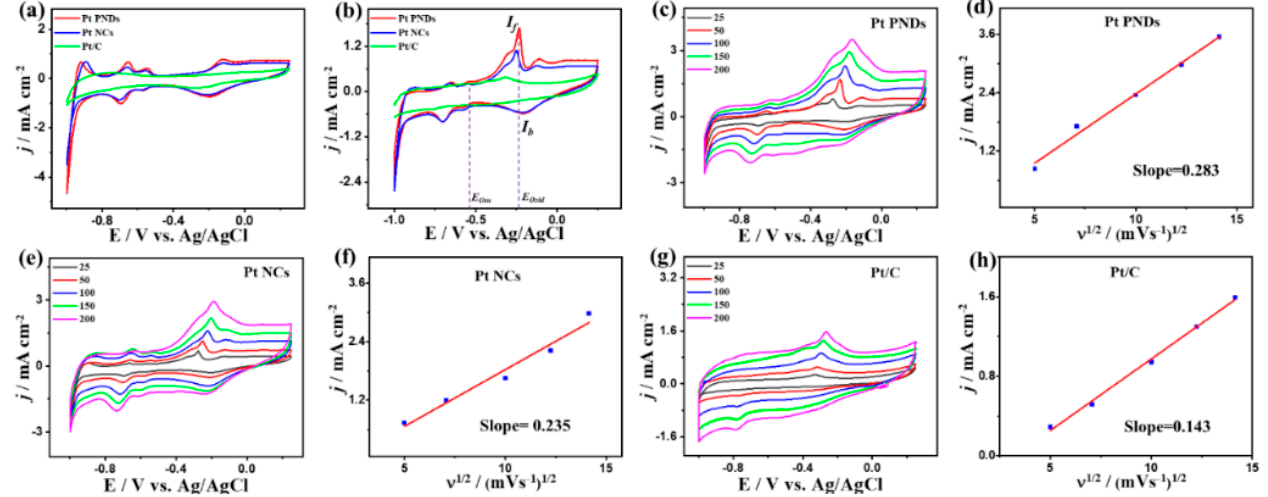
Figure 5. CVs in ( a ) N 2 -staruraed 0.1 M KOH, ( b ) in CO-saturated 0.1 M KOH at 50 mV/s on Pt NDs, Pt NCs, and Pt/C. CV curves at different scan rates and its related plots of I f vs. v 1/2 on ( c , d ) Pt NDs, ( e , f ) Pt NCs, and ( g , h ) Pt/C in CO-saturated 0.1 M KOH.